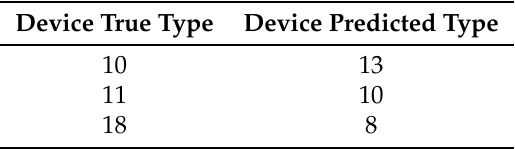
Table 3. Misidentified device type.